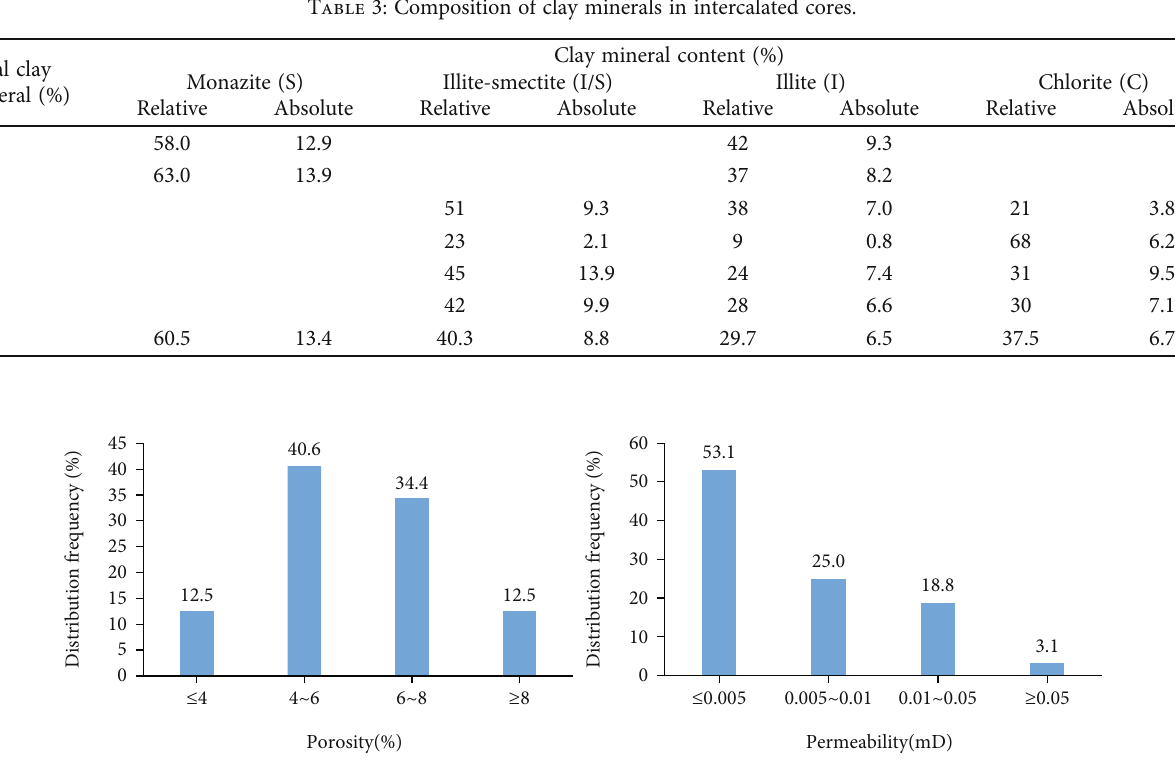
Figure 9: Histograms of porosity and permeability of core samples from